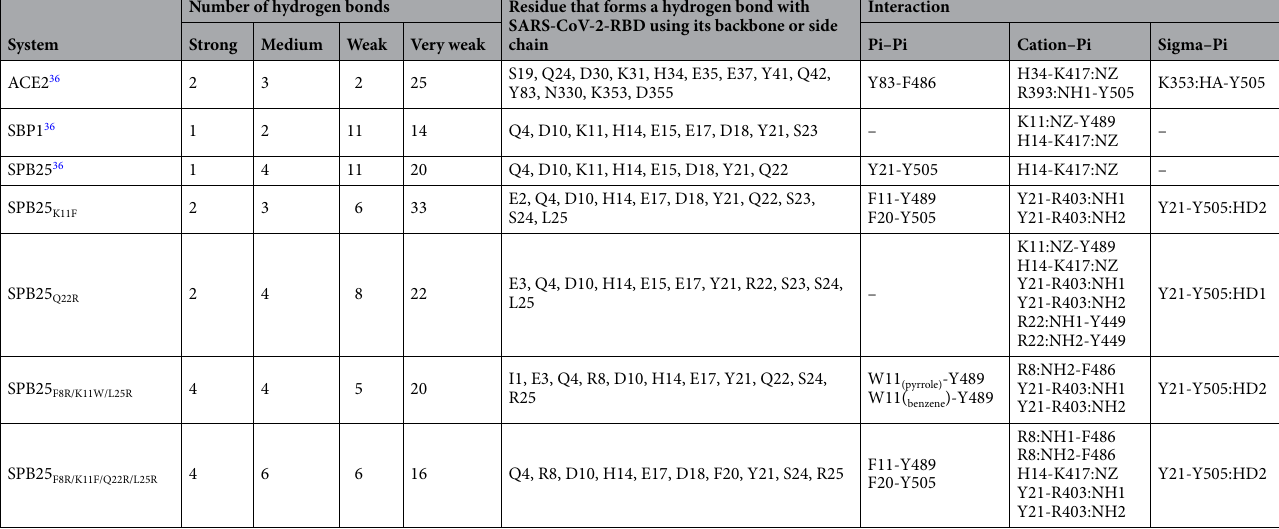
Table 2. Numbers of hydrogen bond and pi interactions of ACE2, SBP1, SPB25 and designed peptides contributing to SARS-CoV-2-RBD